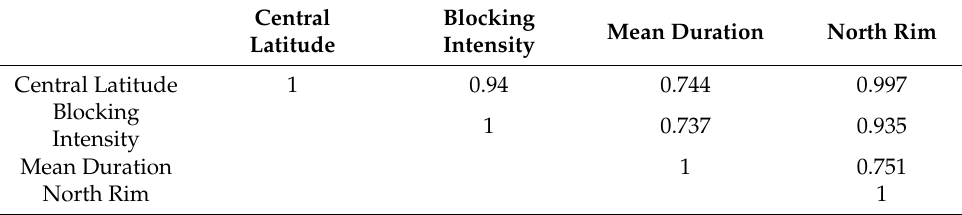
Table 1. The correlation coefficient between indexes of the UB in winter during 1979–2018.